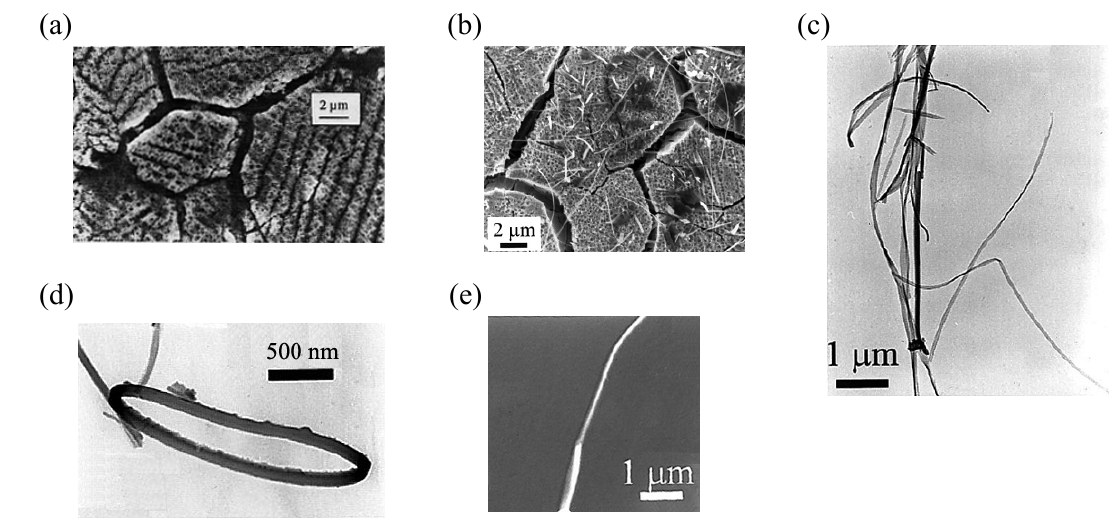
Figure 6. SEM images of (a) native SSCC surface and (b) SSCC surface covered